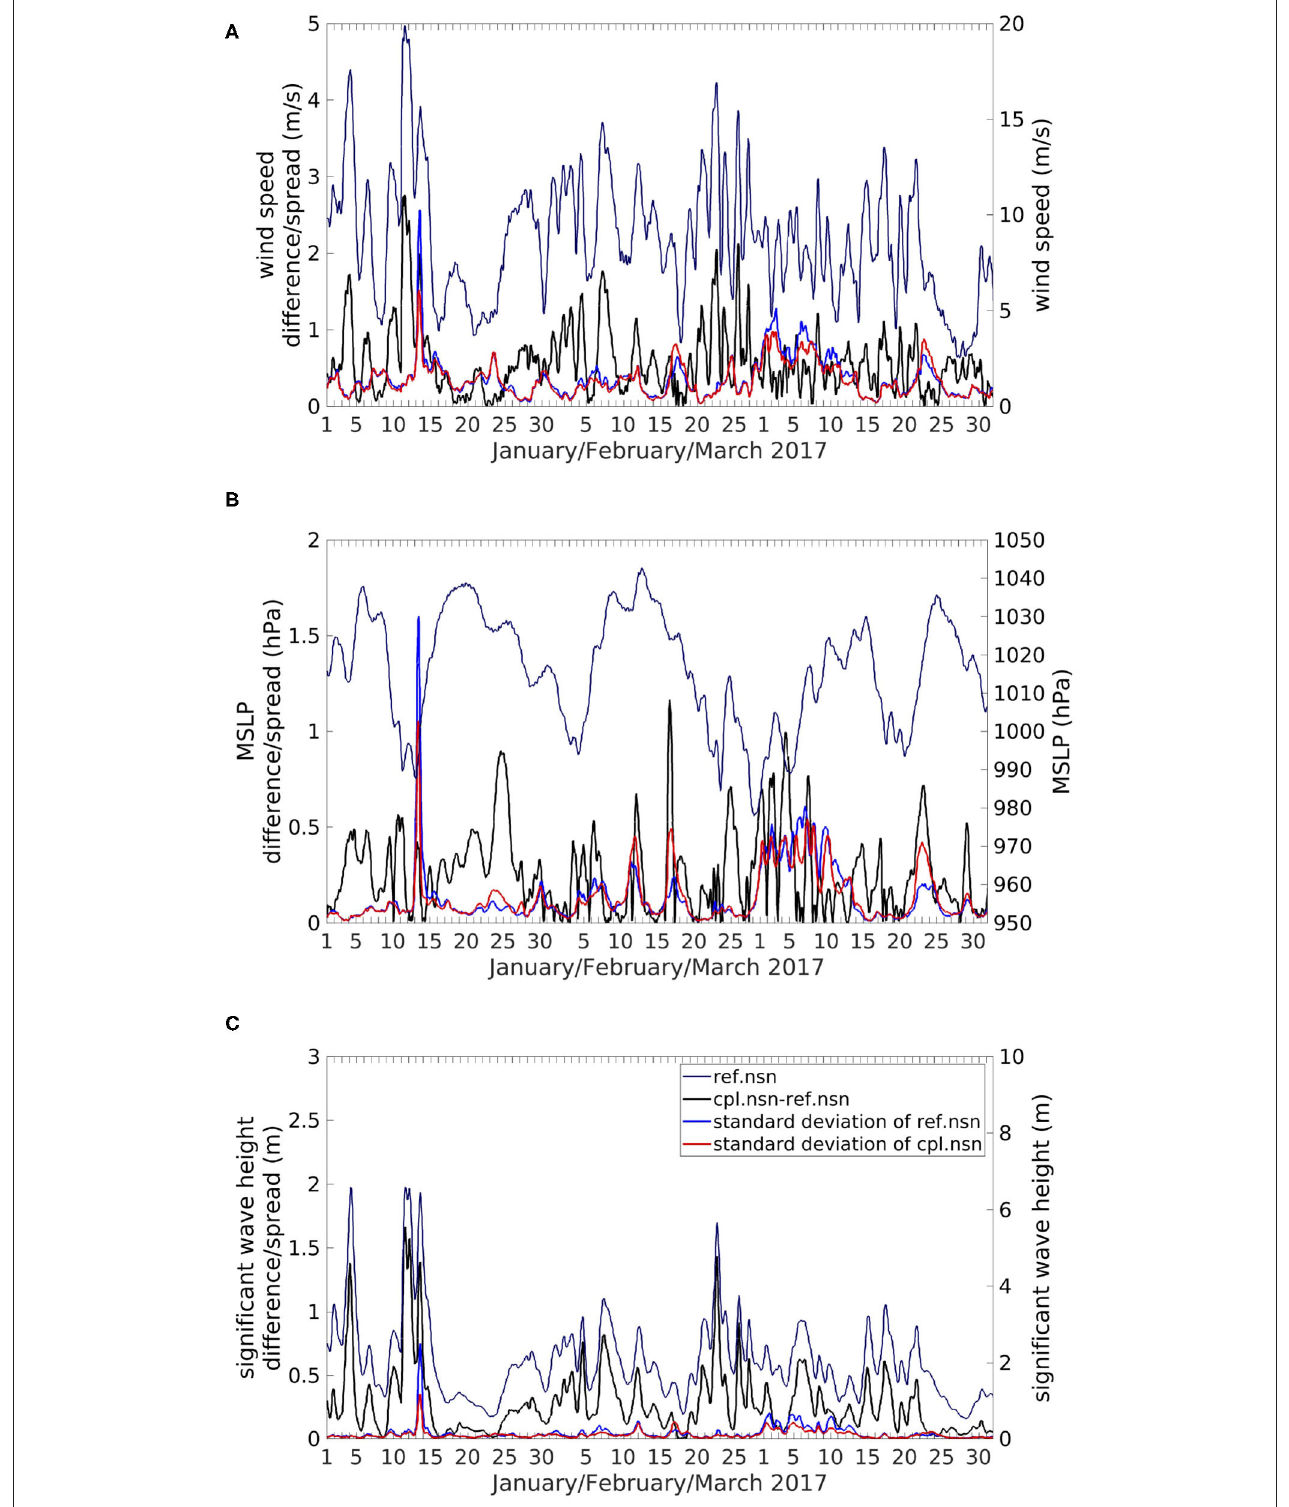
FIGURE 7 | Time series of the absolute differences in the ensemble means (black), standard deviations of the ensembles (red and blue) and values in the reference ensemble (ref.nsn, dark blue, right y-axis) in the North Sea for the wind speed (A) , MSLP (B) , and significant wave height (C) .